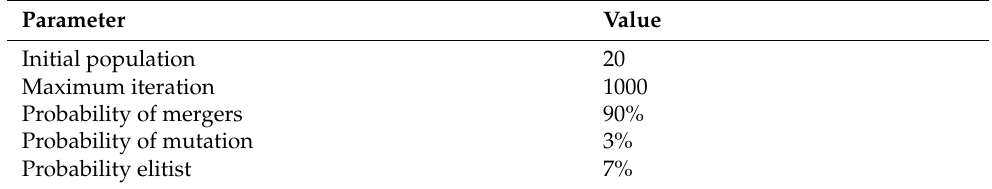
Table 3. Specifications of the